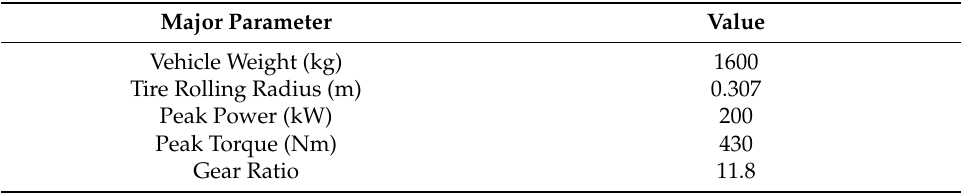
Table 1. Parameters of vehicle and electric